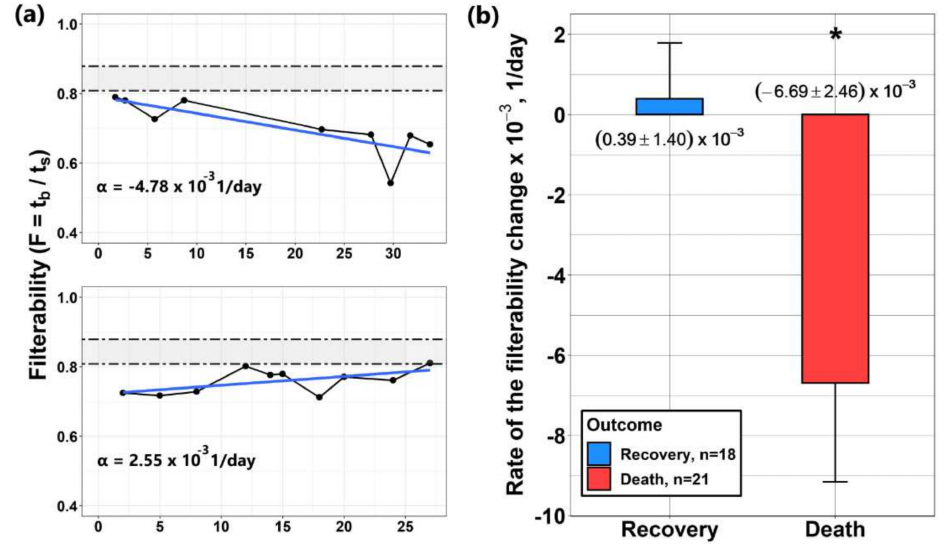
Figure 5. Dynamics of changes in the filterability (F) of erythrocytes in COVID-19 patients. ( a ) Typical examples of the dynamics of changes in the filterability of erythrocytes in two patients, showing that during treatment F can both increase and decrease. Dotted lines indicate the boundaries of normal filterability values. The rates of changes in filterability ( α ) for each of the patients are given. ( b ) Averaged rates of change in filterability in groups of surviving and deceased patients. The average values and standard errors of the mean (SEM) are presented. * The difference between the groups is significant (ANOVA, p <